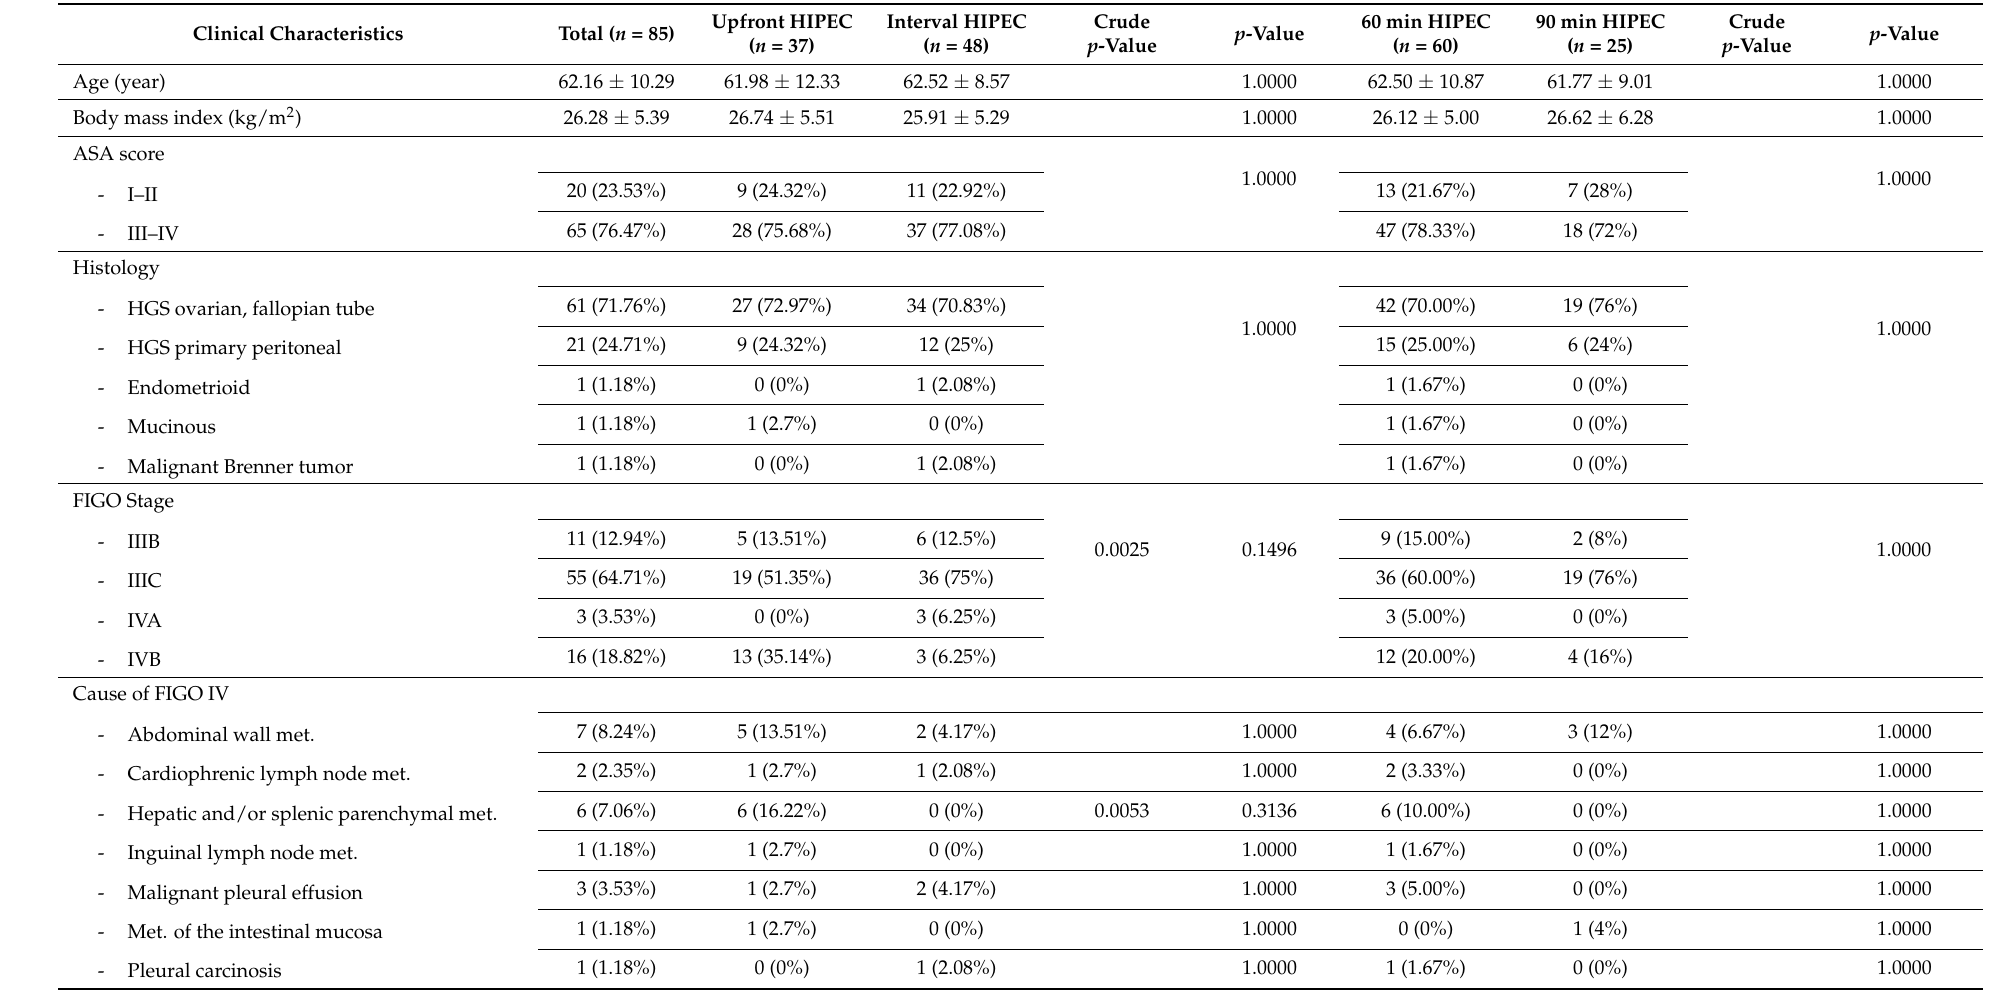
Table 1. Pre-, peri- and postoperative demographic and clinical characteristics of study participants. Unit of frequency data is the number of observations (percentage). Clinical